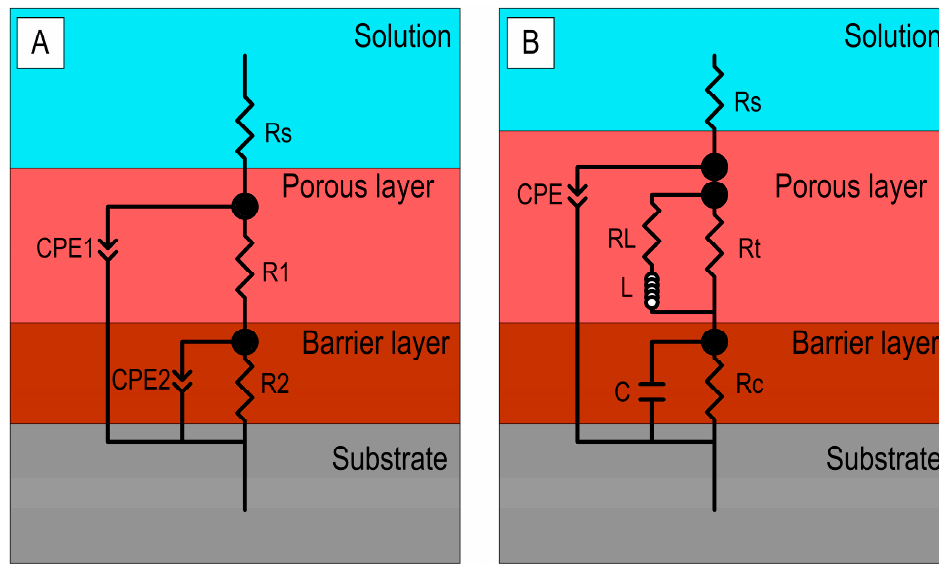
Figure 10. Equivalent circuits proposed based on the fitted results of EIS for samples with MAO coatings formed on titanium alloy in electrolytes without ( A ) and with ( B ) GO additives. The elements of the equivalent circuit simulating an MAO coating formed on titanium alloy in the base electrolyte without GO additives (Figure 10A) are: Rs is the resistance of 3.5% NaCl solution; R1 and CPE1 are the resistor and the constant-phase element, respectively, corresponding to the outer porous layer of the MAO coating; R2 and CPE2 are the resistor and the constant-phase element, respectively, corresponding to the dense barrier layer of the MAO coating. The elements of the equivalent circuit simulating the MAO coating formed in electrolytes with GO additives (Figure 10B) are: Rs is the resistance of 3.5% NaCl solution; Rt is the resistance of the outer porous layer; RL and L are the resistance and inductance, respectively, associated with the presence of graphene oxide (including partially reduced) inside the pores; Rc is the resistance of the dense barrier layer; C is the capacitance of the electrical double layer at the substrate–coating interface; CPE is constant-phase element corresponding to the entire oxide layer of the MAO coating. It can be seen that in addition to the standard R–CPE units responsible for the outer porous and dense barrier (at the boundary with the metal substrate) layers of the MAO coating (Figure 10A), in the case of coatings formed in electrolytes with the oxide graphene additives (Figure 10B), to describe the loops in the Nyquist diagram (Figure 9B), the resistor RL and the inductance L are introduced into the equivalent circuit, which is due to the presence of graphene oxide (including partially reduced) inside the pores (Figure 5). The values of the parameters of equivalent circuit elements (Figure 10), proposed based on the fitted results of EIS, for samples with MAO coatings formed on titanium alloy in electrolytes without and with GO additives, are presented in Table